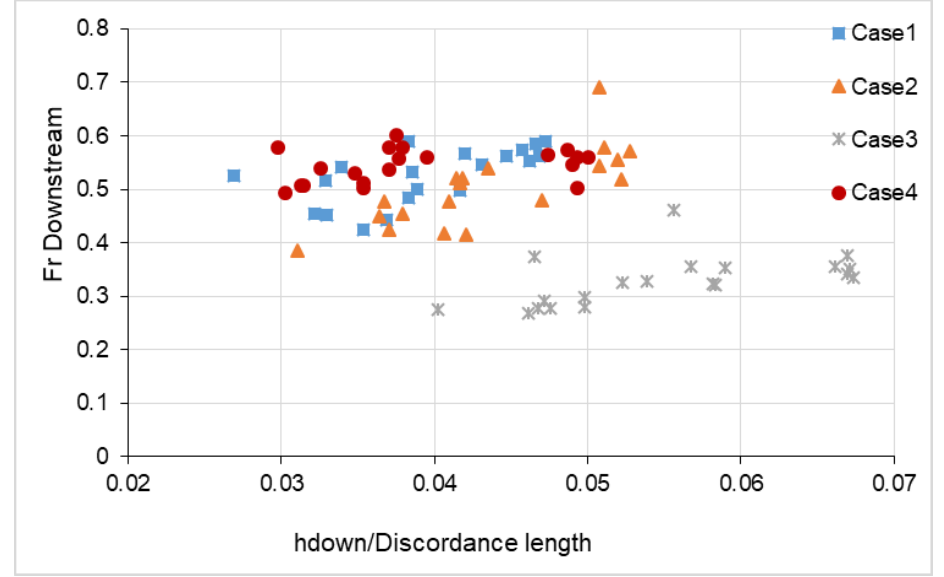
Figure 8. Relation between downstream Froude number and h_downstream⁄(Discordance